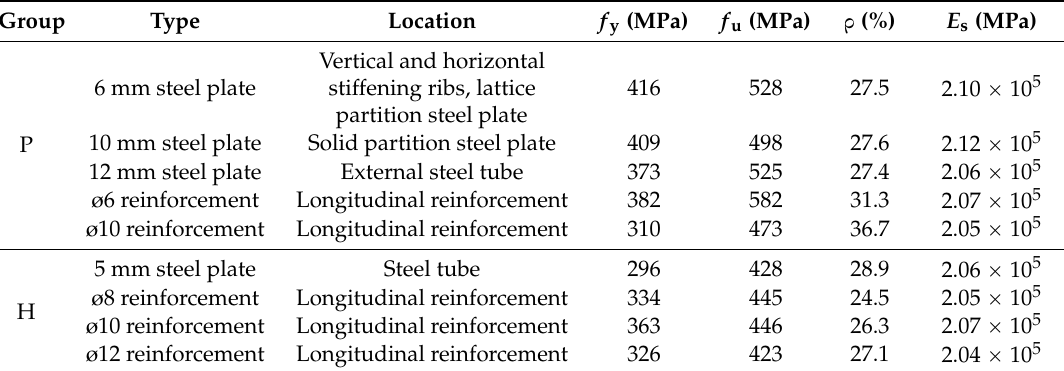
Table 2. Mechanical properties of reinforcement and steel plates.